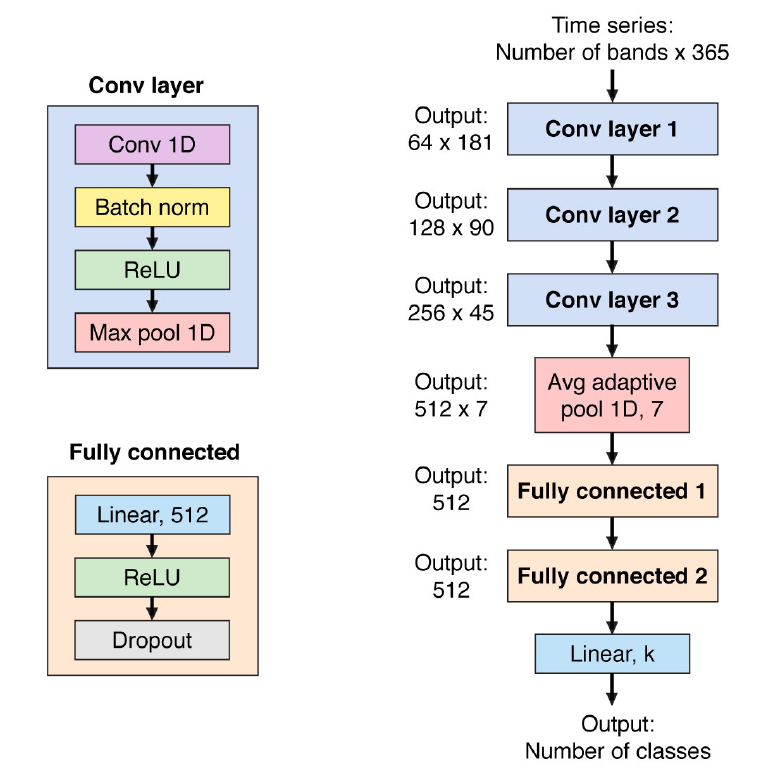
Figure A11. 1D CNN architecture.